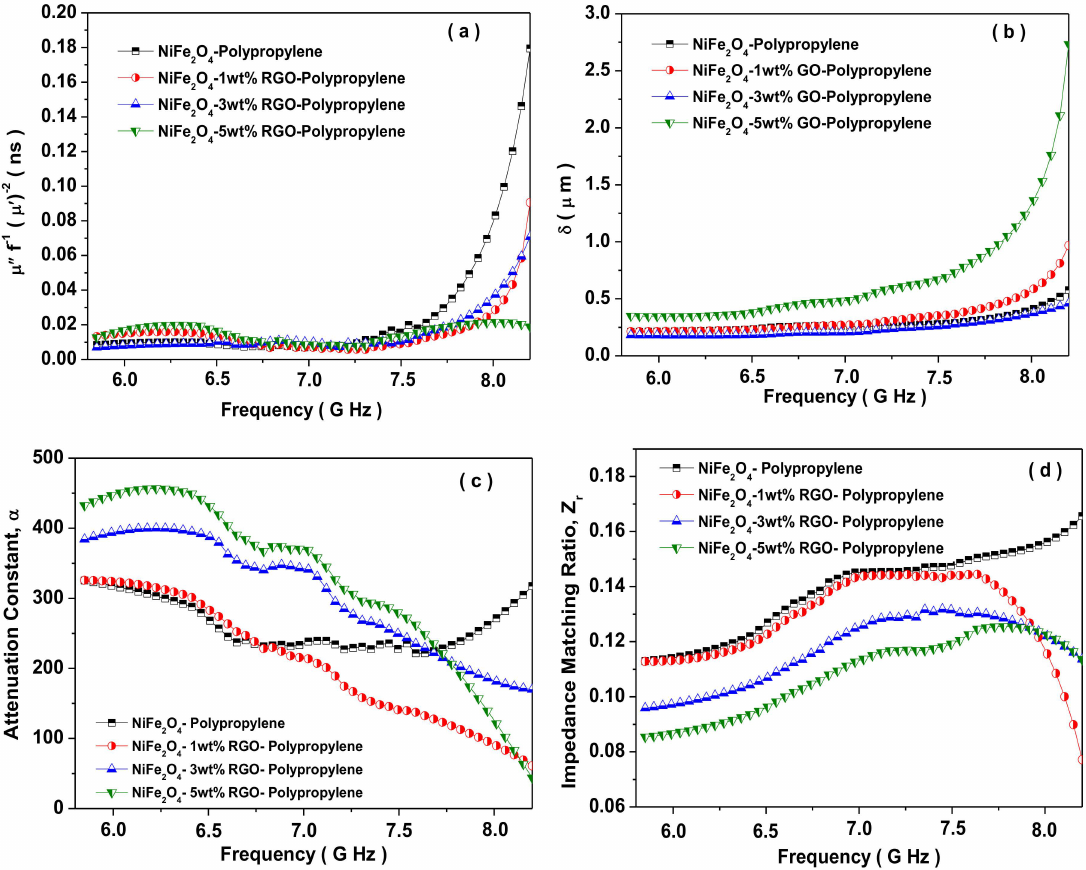
Figure 13. ( a ) Eddy current loss, ( b ) skin depth, ( c ) attenuation constant, ( d ) impedance matching for NiFe 2 O 4 -Polypropylene, NiFe 2 O 4 -1wt%RGO-Polypropylene, NiFe 2 O 4 -3wt%RGO-Polypropylene,